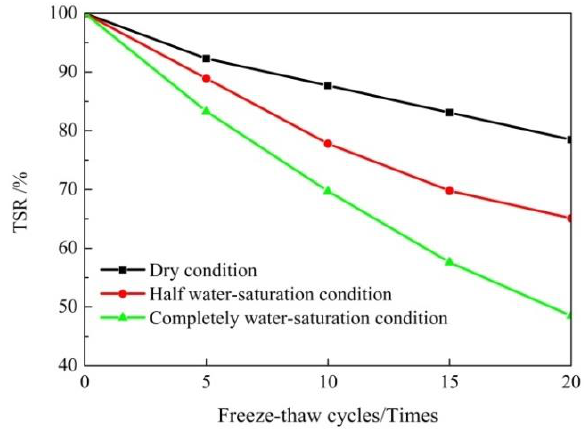
Figure 7. TSR under freeze – thaw cycles with different water saturation